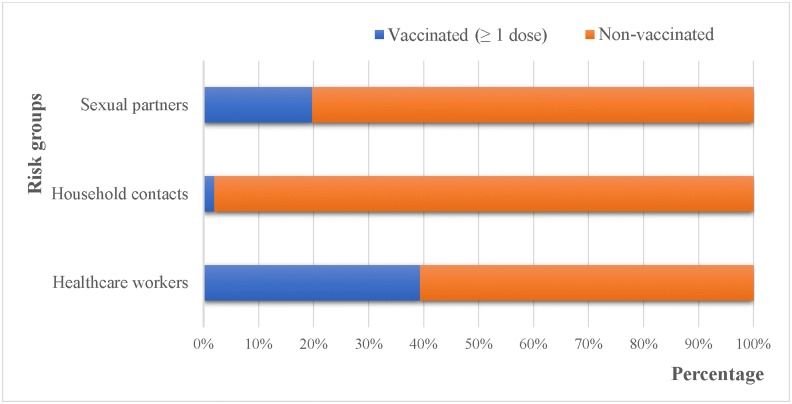
Vaccinated versus non-vaccinated populations in the high-risk groups.